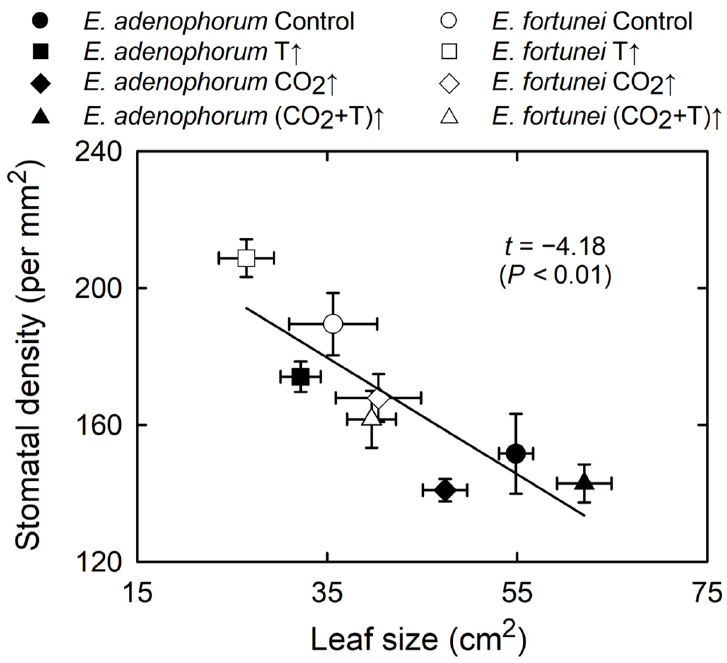
Figure 7. The relationship between stomatal density and leaf size across species and treatments. Points are means ± SE per treatment and species. A linear mixed model was fitted to the data with species as a random factor.